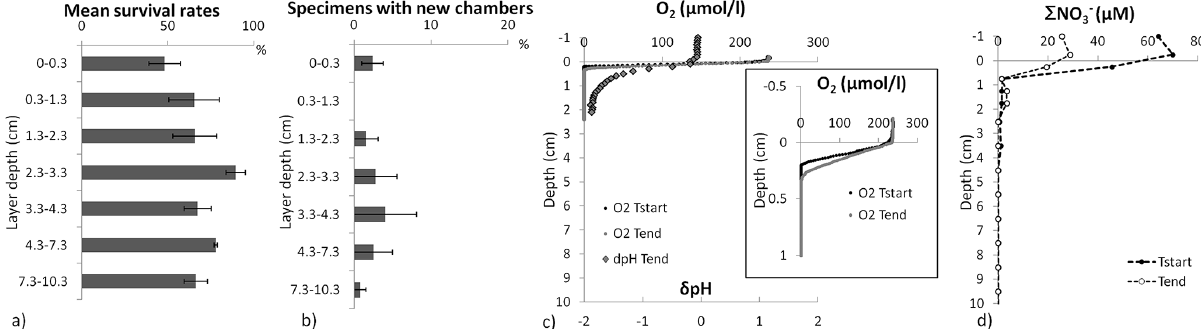
Figure 3. Main results of experiment 1 with Ammonia tepida . (a) Mean survival rates; (b) specimens that calcified new chambers; (c) oxygen and δ pH profiles; (d) nitrate profiles. δ pH is calculated as the difference between measured values at various sediment depths and the pH value measured in overlying water. Error bars represent the mean standard error.